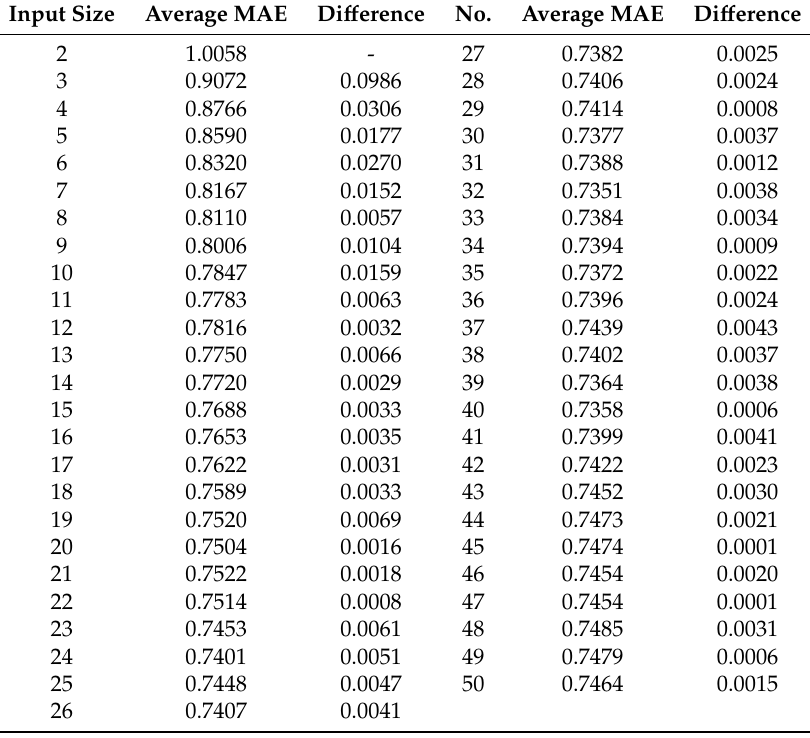
Table 12. Change in the average of MAE and di ff erence for each range (the item-based filtering: the Pearson correlation coe ffi cient).